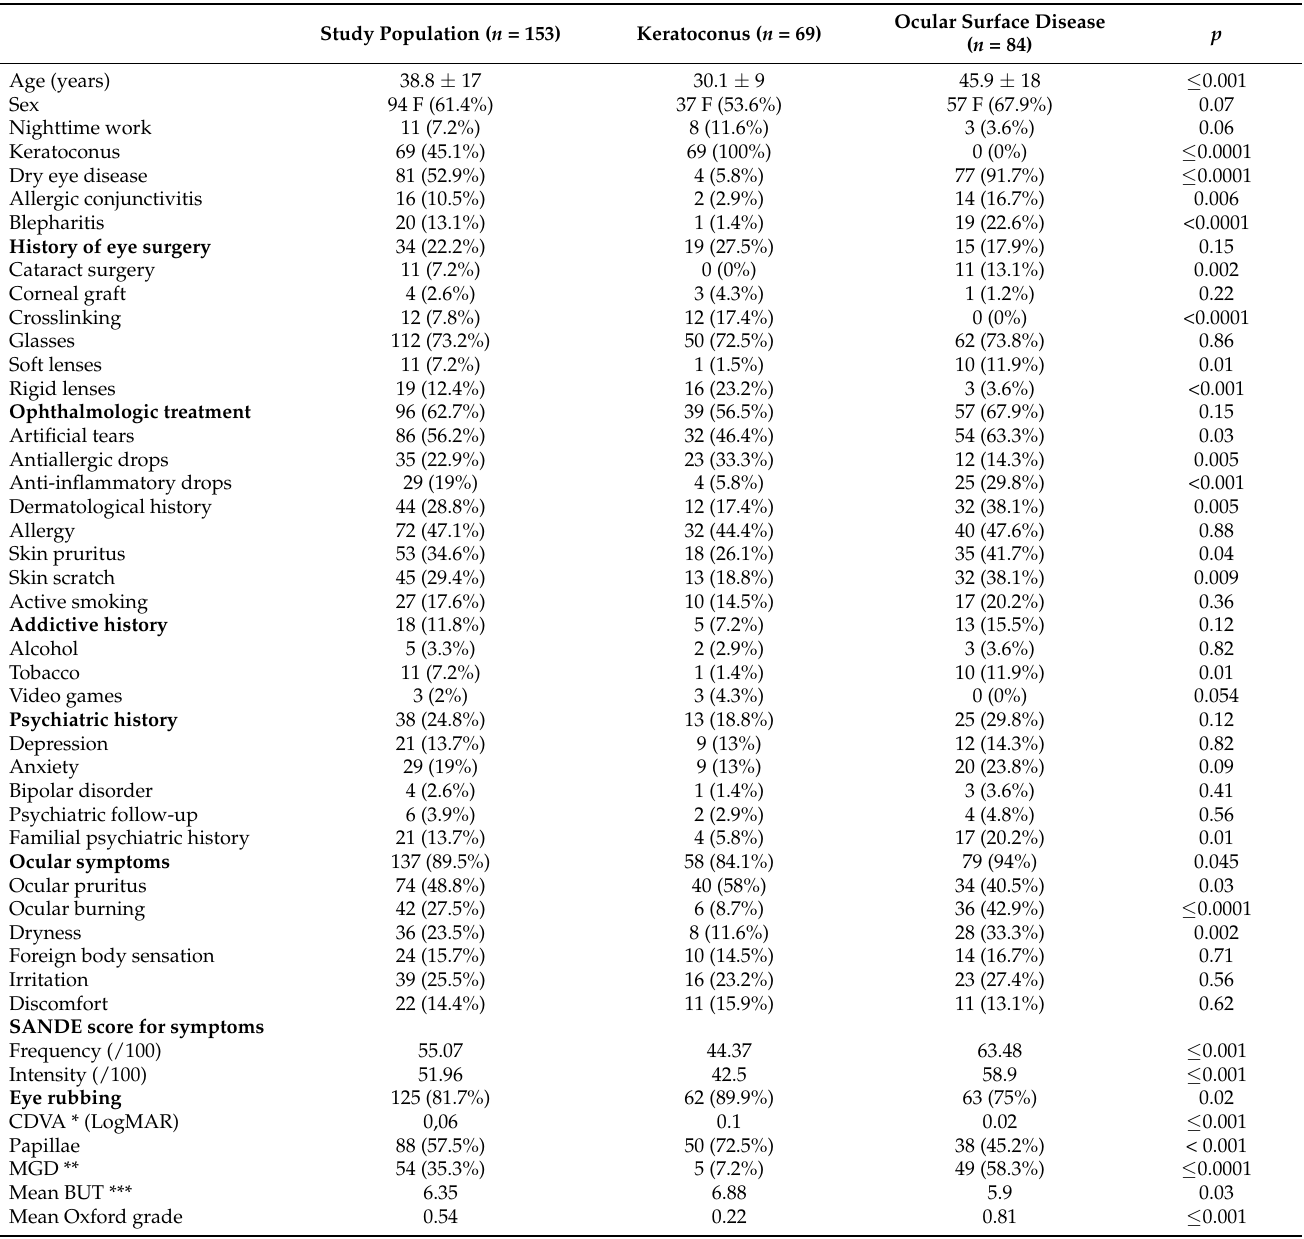
Table 1. Characteristics of the study population: Keratoconus (KC) and Ocular Surface Disease (OSD)